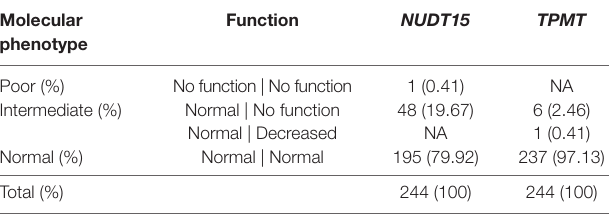
TABLE 3 | Distribution of predicted enzymatic metabolizer